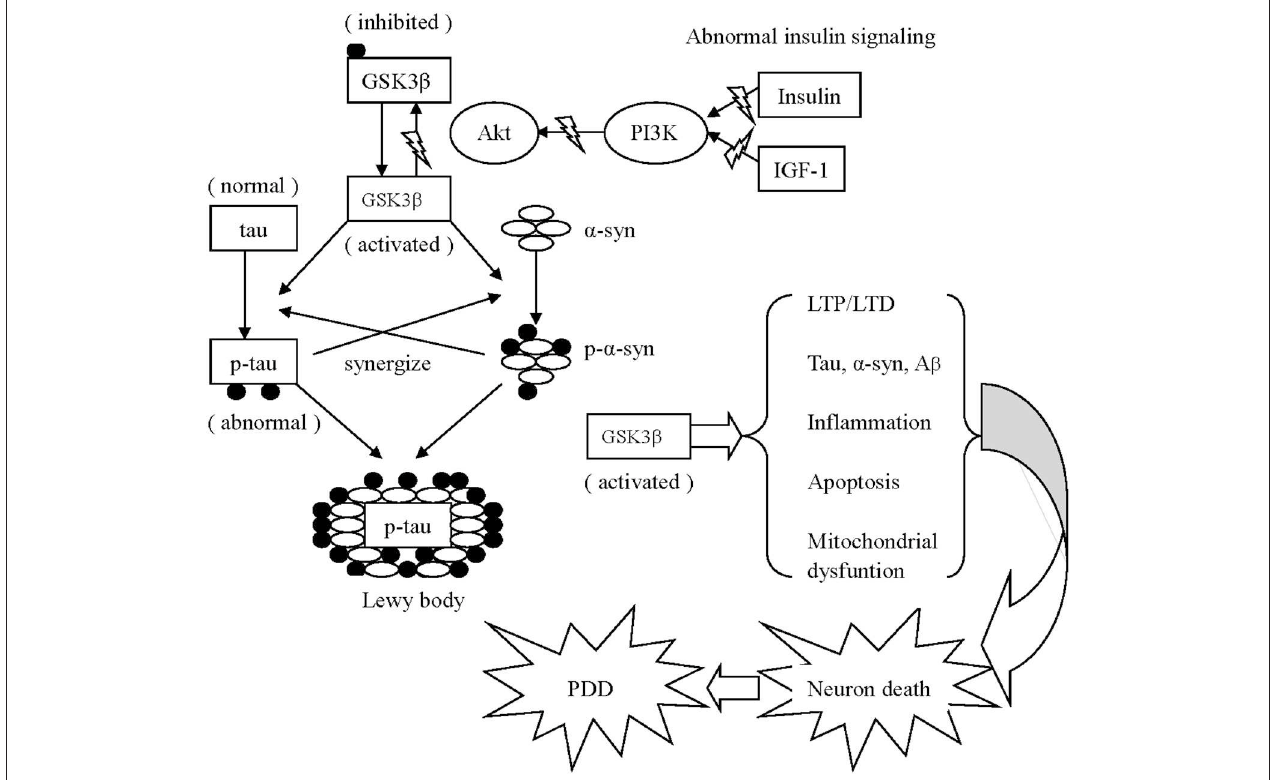
FIGURE 2 | Schematic drawing of several mechanisms associated with GSK3 β appear to contribute to PDD 1. Activated GSK3 β is known to hyper-phosphorylate tau, which leads to intracellular accumulation and failure to bind and assemble microtubules. Meanwhile, α -synuclein phosphorylation is also enhanced via activated GSK3 β . Additionally, the phosphorylated α -synuclein and tau enhance the phosphorylation of unphosphorylated α -synuclein and tau of each other to accelerate the progress of neurodegeneration. Similarly, α -synuclein could work in coordination with A β to increase cytotoxicity. Both α -synuclein and A β overexpression are associated with elevated levels of active GSK3 β , resulting in increased tau hyper-phosphorylation. 2. Activated GSK3 β impairs long-term memory in hippocampal-associated tasks via imbalanced LTP and LTD. 3. The GSK3 β -related imbalance of pro-inflammation and anti-inflammation continuously aggravates PD pathology. 4. Activated GSK3 β negatively effects mitochondrial function, elevates the expression of caspase-3 and caspase-9, and ultimately induces neuronal